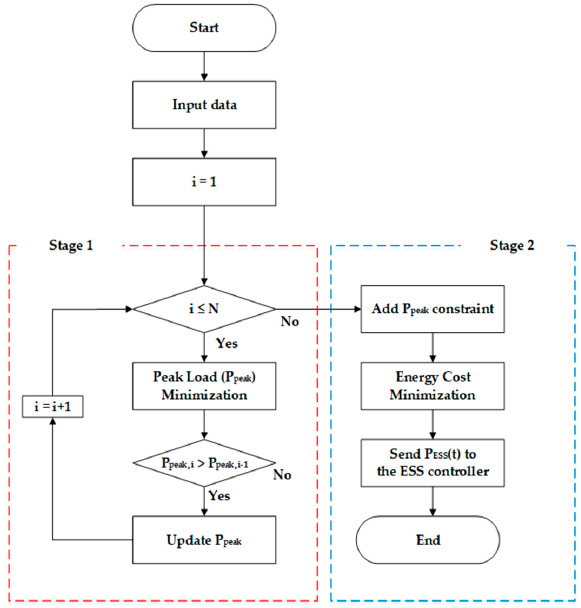
Figure 3. Flowchart of the proposed energy storage system (ESS) optimization algorithm.